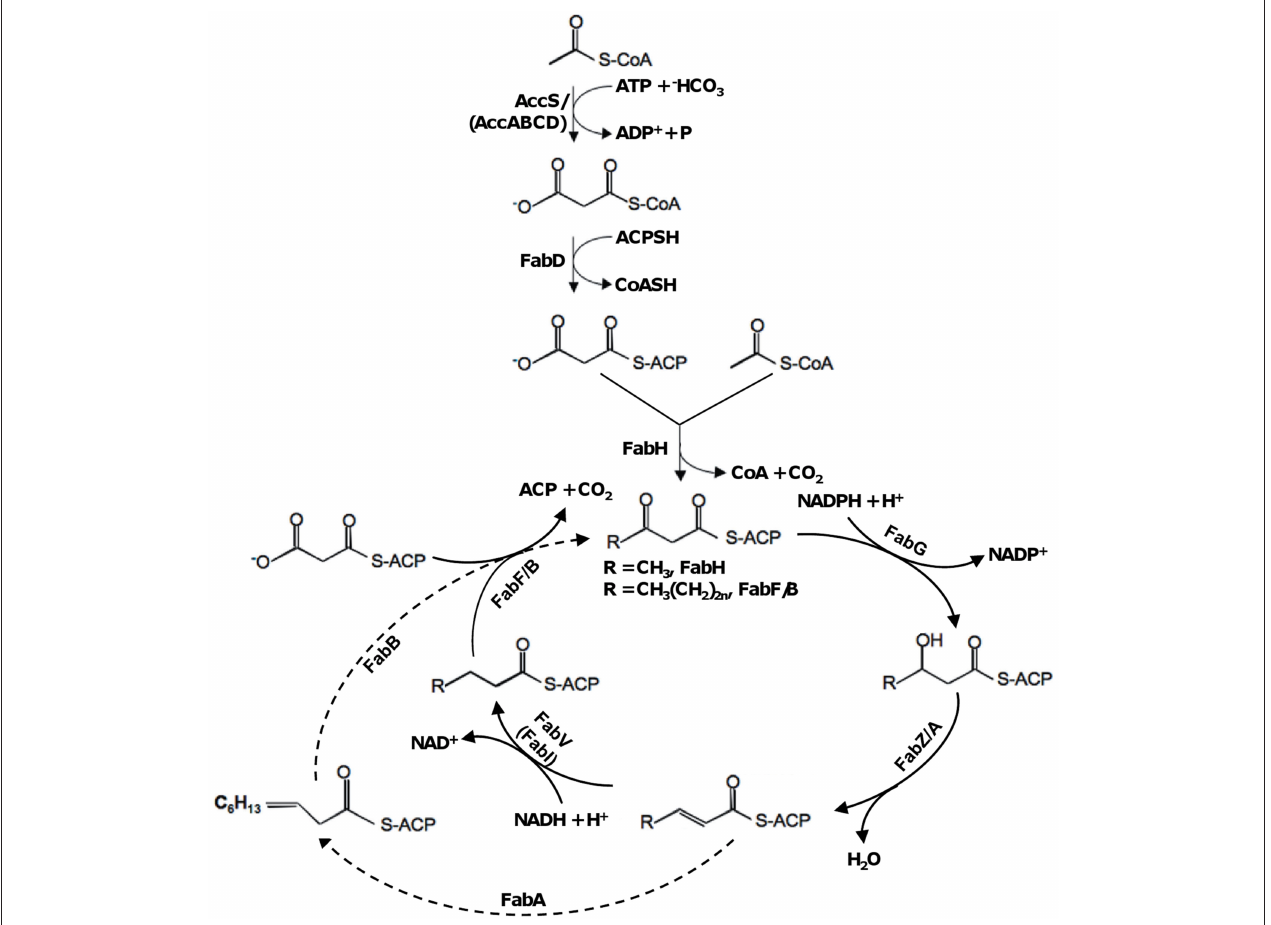
FIGURE 1 | Type II fatty acid synthesis in bacteria based on the E. coli paradigm. In S. oneidensis , homologs of two E. coli enzymes, AccABCD and FabI, are not found and replaced by AccS and FabV (as in V. cholerae and P. aeruginosa ), respectively. Dash line represents the steps specific to UFA